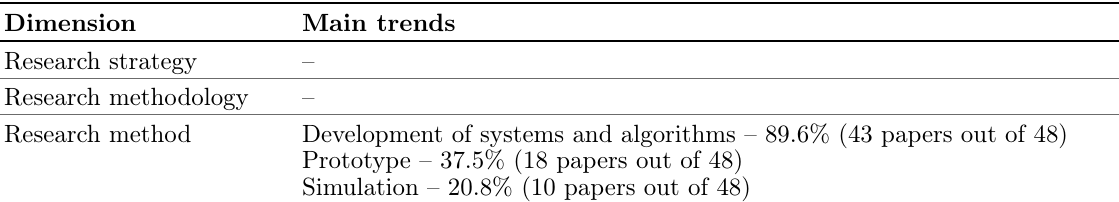
Table 15. Summary of research and methodology aspects (based on Tables 8, 9, and 10). Dimension